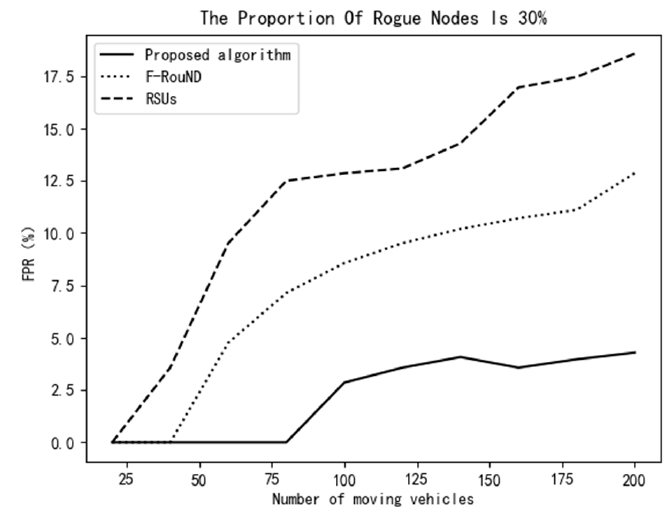
Figure 12. Variation of FPR vs. the number of mobile vehicles (30%).